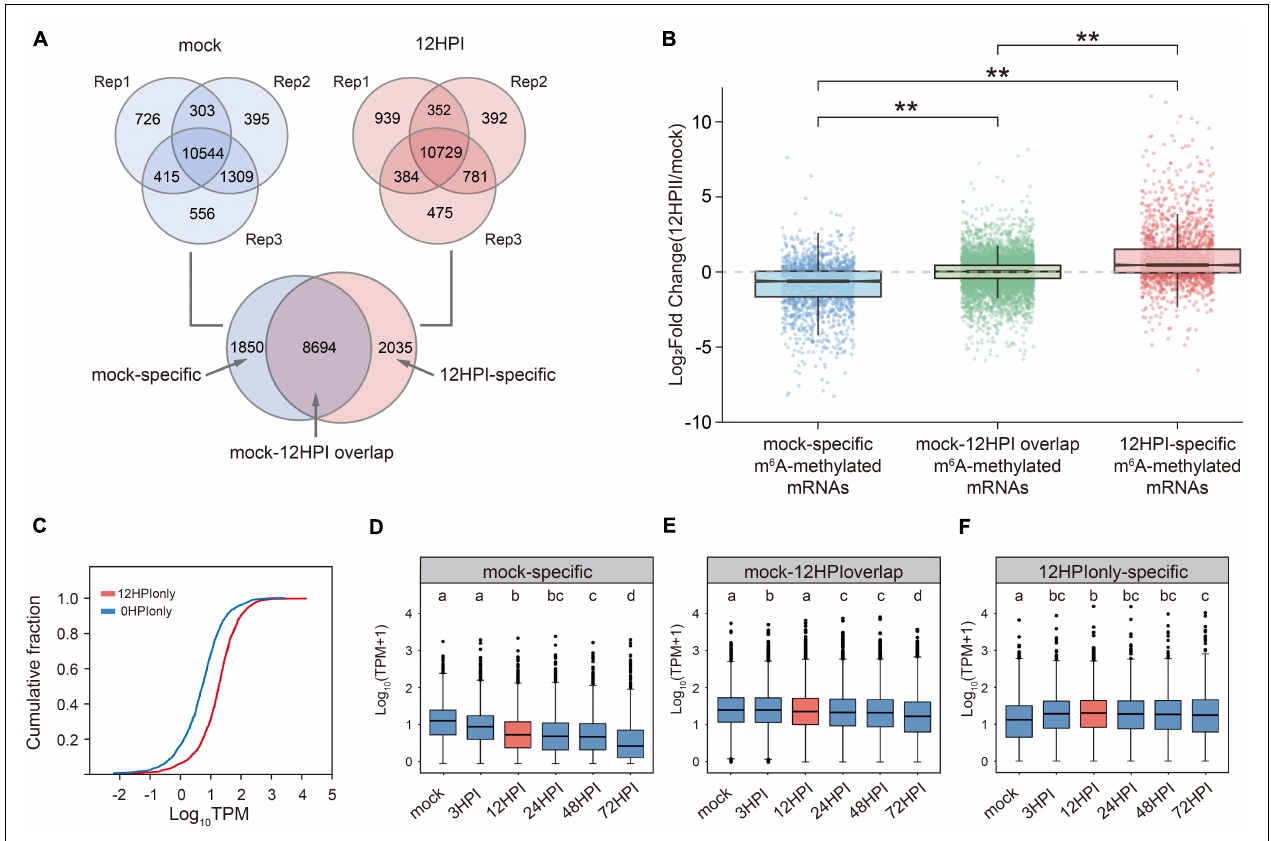
FIGURE 3 | Fire blight inoculation induces changes in transcriptome-wide m 6 A modification, resulting in the increase of RNA abundance of m 6 A modified transcripts. (A) Overlap of m 6 A-modified genes among three replicates of mock (blue circles) and 12 HPI (red circles), the intersection of replicates indicates high-confidence m 6 A-modified genes. The subset of 0 HAI and 12 HAI indicates specifically m 6 A-modified genes before and after blight inoculation. (B) Relative abundance of m 6 A-modified gene transcripts in mock to 12 HPI contain mock-specific (blue box), 12 HPI–specific (red box), and mock-12 HPI overlap (green box). * p < 0.05; ** p < 0.01. (C) Cumulative distribution function (CDF) of the relative abundance (12 HPI divided by mock) of transcripts in mock-specific m 6 A-modified genes and 12 HPI–specific m 6 A-modified genes compared using the Wilcoxon t -test. (D–F) Expression pattern of m 6 A-modified genes at different time points after